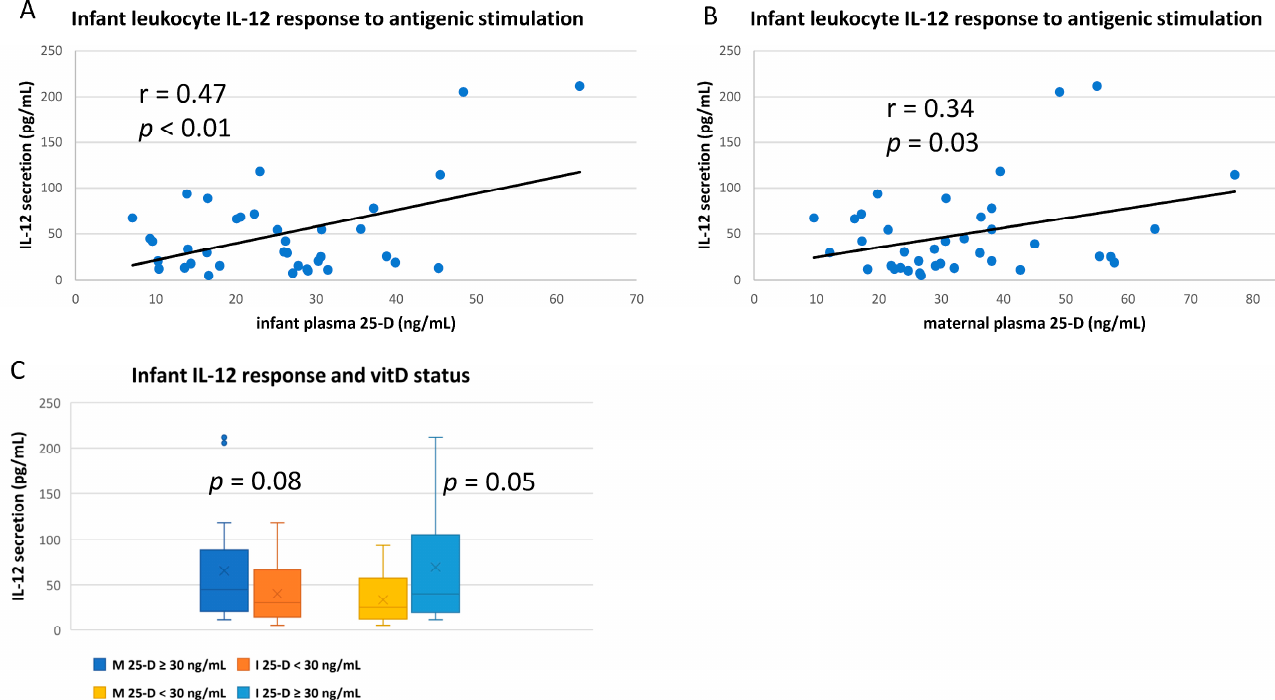
Figure 7. IL-12 responses of infant leukocytes to in vitro antigenic stimulation. Whole blood from breastfeeding infants was antigen-stimulated and culture supernatants analyzed for IL-12 content. Cytokine release after stimulation correlated to ( A ) infant’s own plasma 25-D or ( B ) maternal plasma 25-D. ( C ) Mean infant IL-12 responses after antigenic stimulation compared between groups based on both infant (I) and maternal (M) vitD sufficiency (plasma 25-D ≥ 30 ng/mL) at the corresponding time of blood draw.